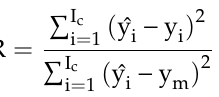
Table 5. The extraction values of the characteristic wavelengths for different numbers of cycles.